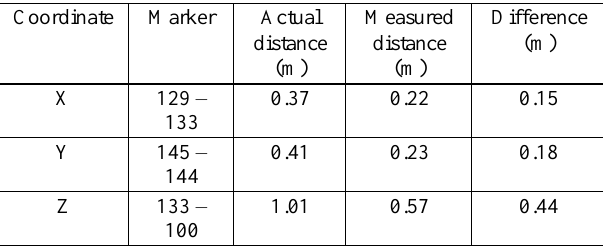
Figure 9 Equation for calibration coordinate Table 2 Calibration result for coordinate X, Y and Z